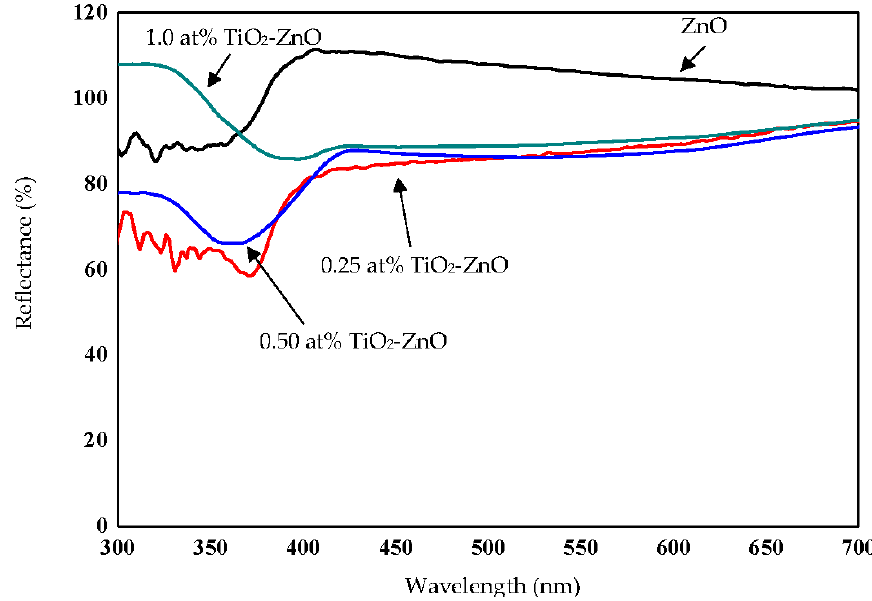
Figure 15. Reflectance spectra of ZnO, 0.25 at % TiO 2 -ZnO, 0.50 at % TiO 2 -ZnO, and 1.0 at % TiO 2 -ZnO.